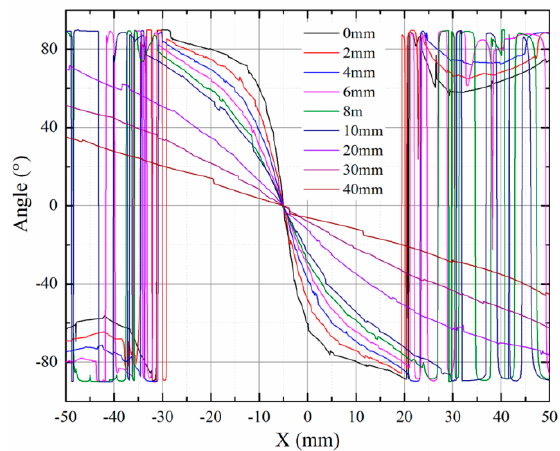
Figure 5. Variation of the angle α over z-height.